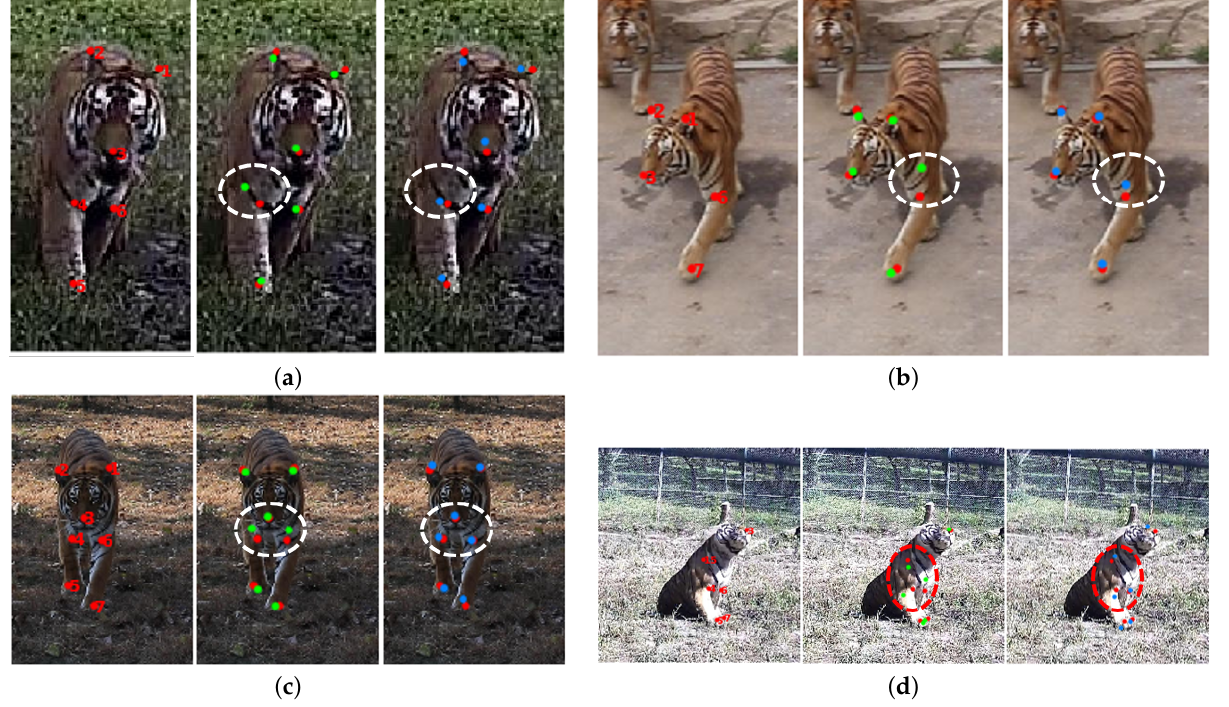
Figure 7. Qualitative Results: ( a ) underexposed; ( b ) motion blur; ( c ) complex background (similar to tiger body texture); ( d ) overexposure. The red point, green point, and blue point represent the ground truth, the initially estimated pose, and the refined pose, respectively. The number represents the index of the joint [24]. Both the red and white dashed circles indicate significant